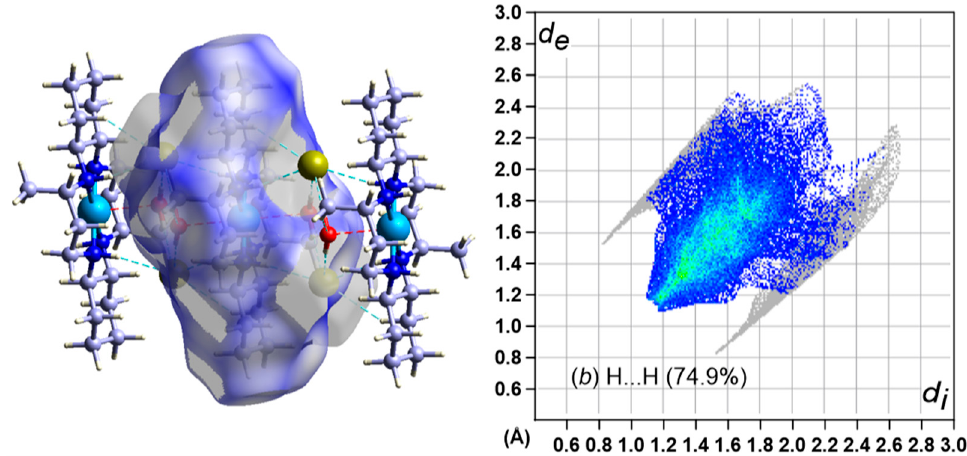
Figure 7. Hirshfeld surface mapped with ( left ) d norm , and 2D fingerprint plot ( right ) for H···H interaction.